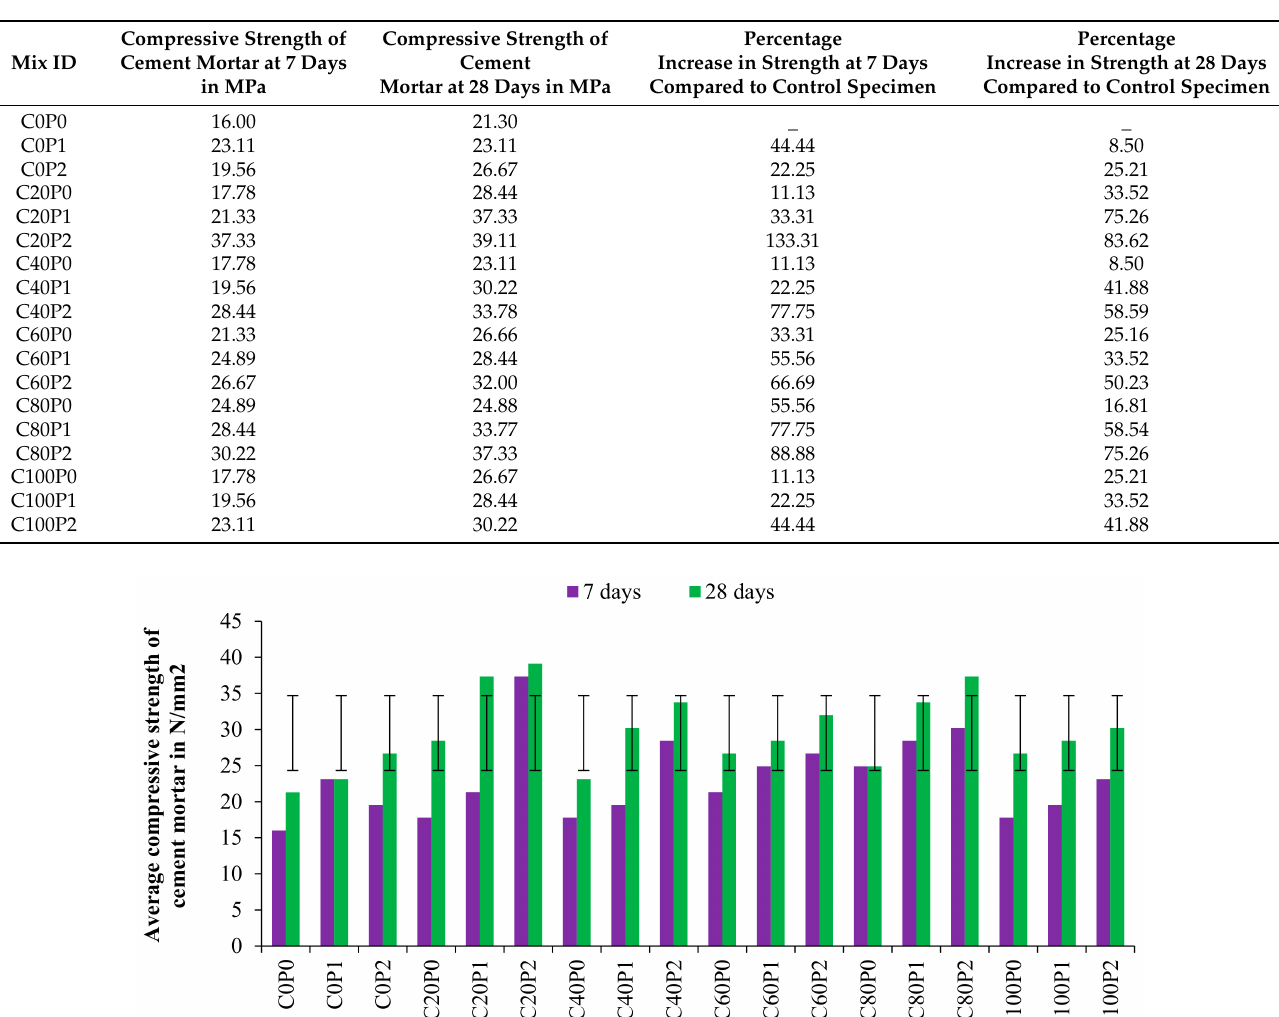
Table 6. Compressive strength of cement mortar cubes.